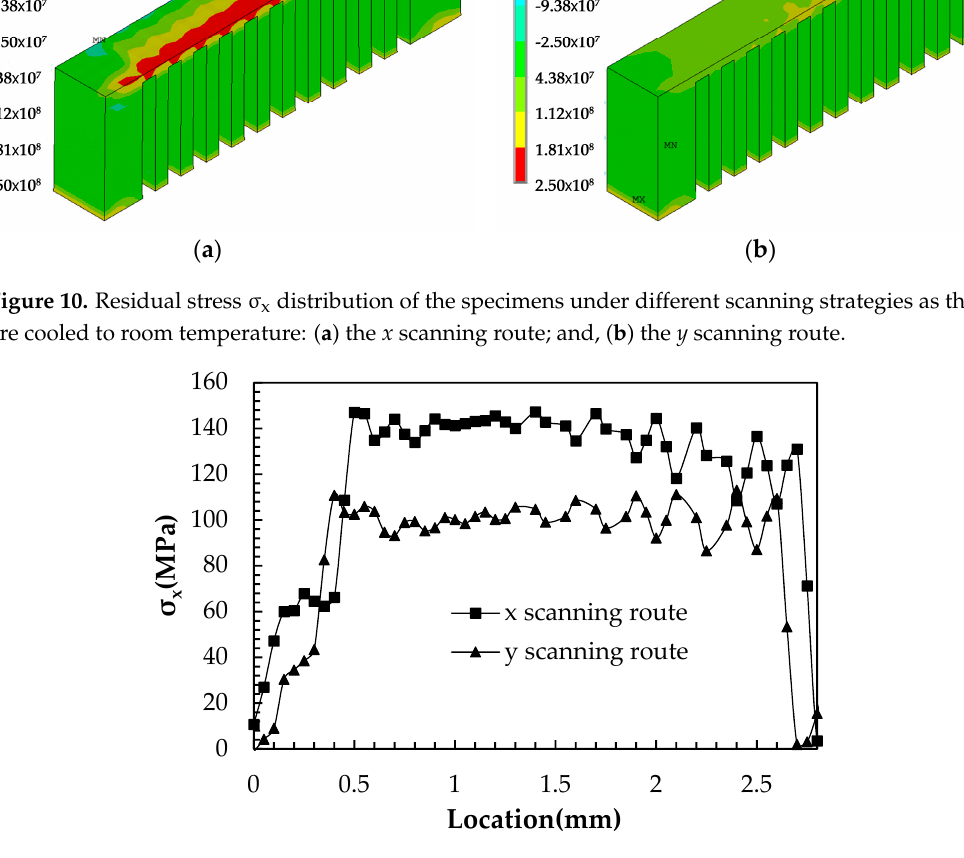
Figure 11. Residual stress σ x distribution of the specimens under different scanning strategies as cooled to room temperature along the X path.